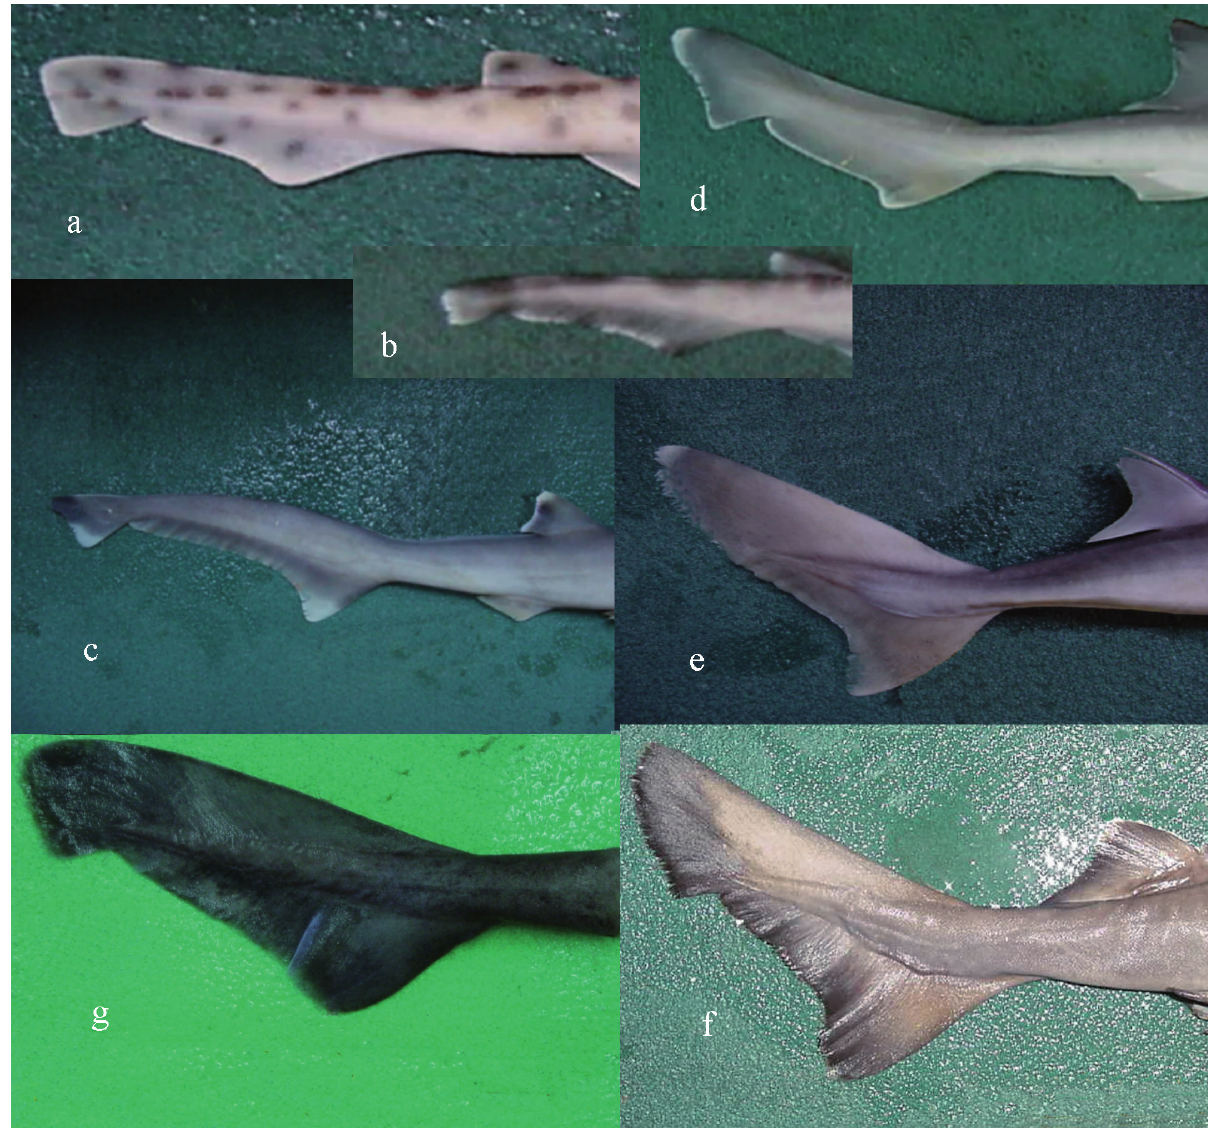
Fig . 3. – Digital photos of heterocercal tail fins of the seven investigated demersal sharks. (a): Scyliorhinus canicula , ? , 245 mm tl; (b): Galeus melastomus , ? , 280 mm tl; (c): Heptranchias perlo , ? , 600 mm tl; (d): Mustelus asterias , / , 480 mm tl; (e): Squalus blainvillei, / , 525 mm tl; (f): Centrophorus uyato , / , 710 mm tl; (g): Dalatias licha / , 535 mm